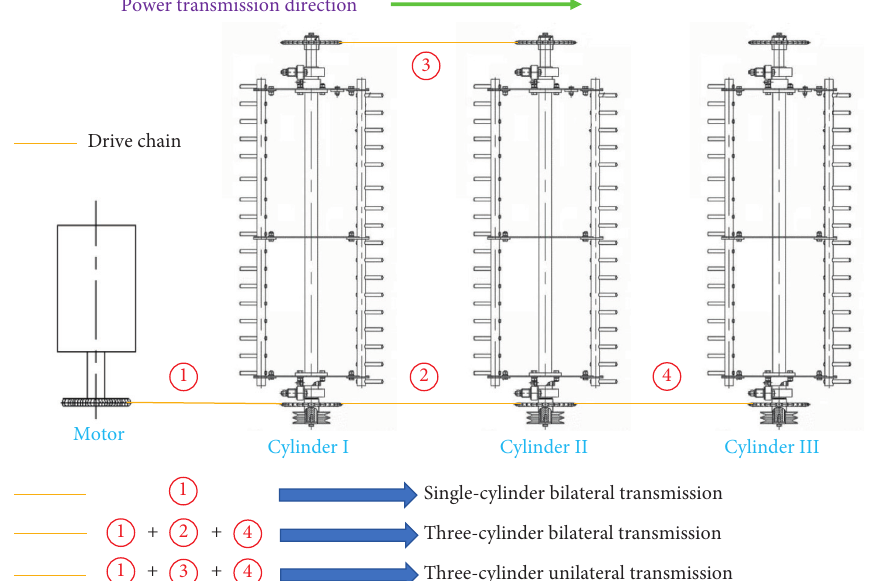
Figure 4: Schematic diagram of multicylinder transmission modes.